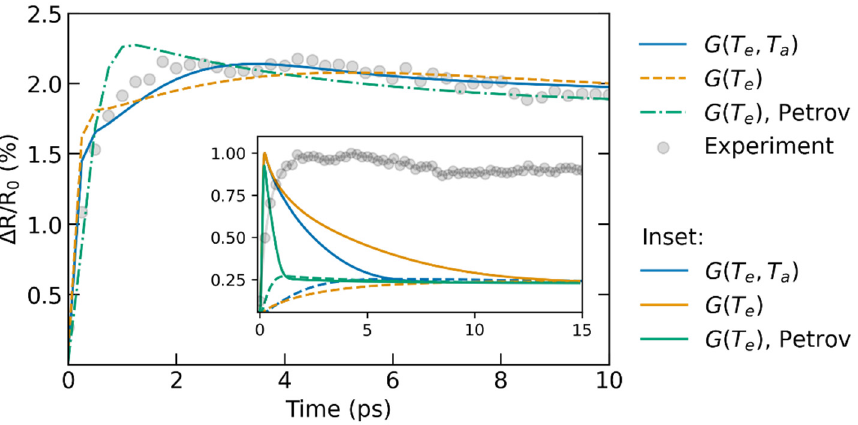
Figure 6. Thermoreflectance data fitted by Equation (4). Temperature profiles were calculated using three electron–ion coupling parametrizations: coupling with linear T a -dependence (1) (blue solid line), the same coupling without linear to T a term (orange dashed line), and T e -dependent coupling provided by Petrov et al. [23] (green dash-dotted line). The inset shows normalized electronic and atomic temperature profiles calculated with TTM vs thermoreflectance data. Solid lines correspond to T e , dashed ones to T a